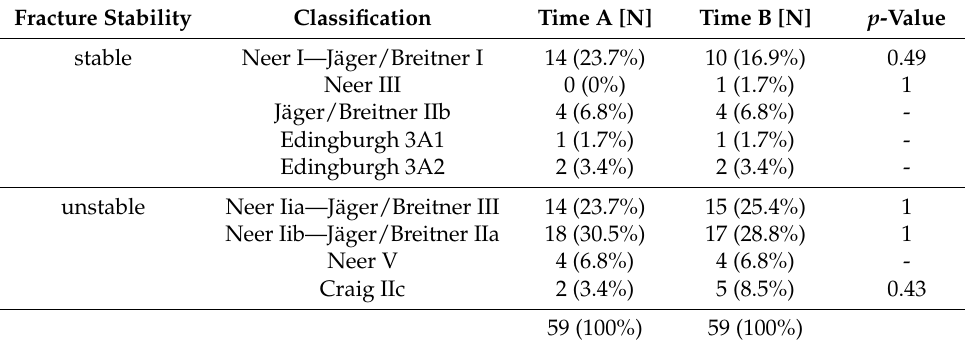
Table 1. Distribution of fracture classification at times A and